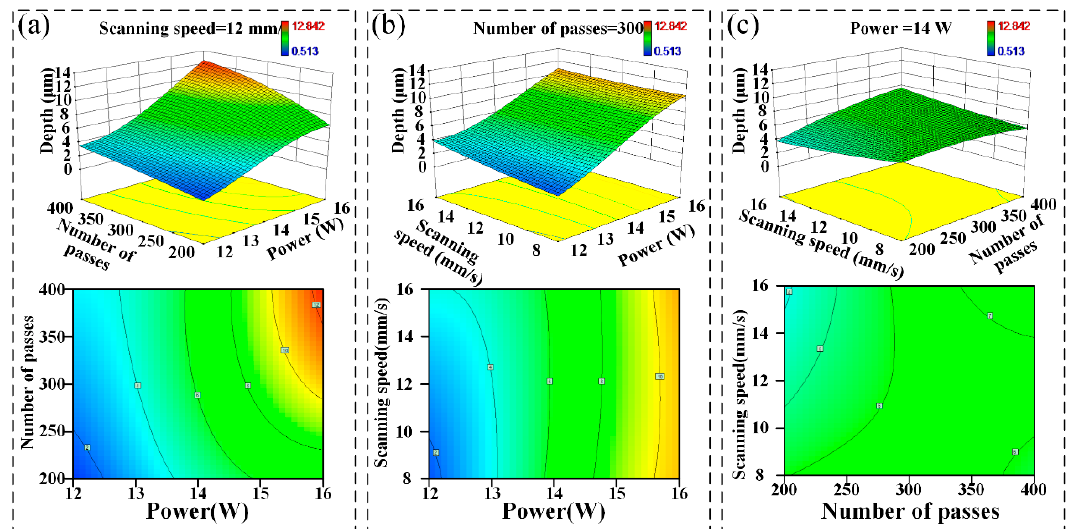
Figure 10. Variations of depth with different laser process parameters: ( a ) effects of number of passes and power on depth; ( b ) effects of scanning speed and power on depth; ( c ) effects of scanning speed and number of passes on depth.